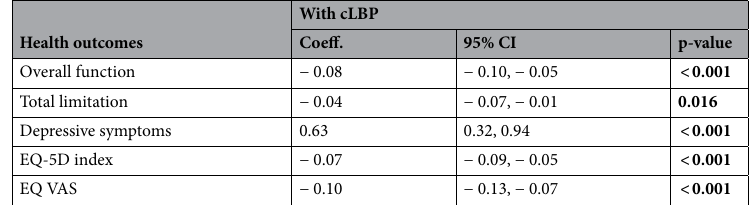
Table 4. Association between chronic low back pain and health outcomes using generalized linear models. Significant values are in bold. cLBP chronic low back pain, Coeff. beta coefficient, 95% CI 95% confidence interval. Variables adjusted in all the models were: sex, marital status, living arrangement, occupation groups, and financial status, smoking status, alcohol misuse, and number of diagnosed chronic morbidities. Age was excluded from the model due to